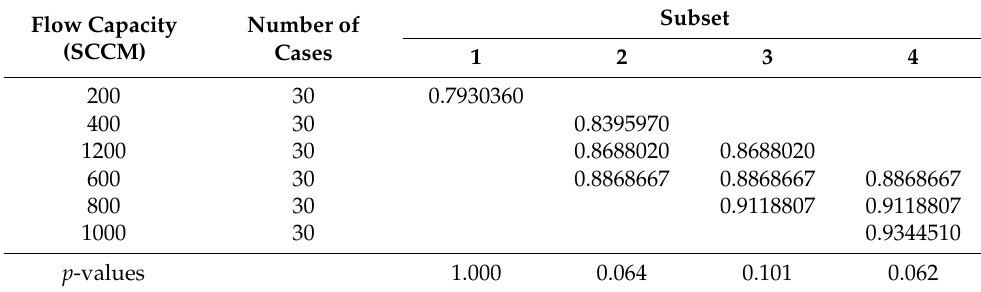
Table 4. LSD comparison of NO sensor